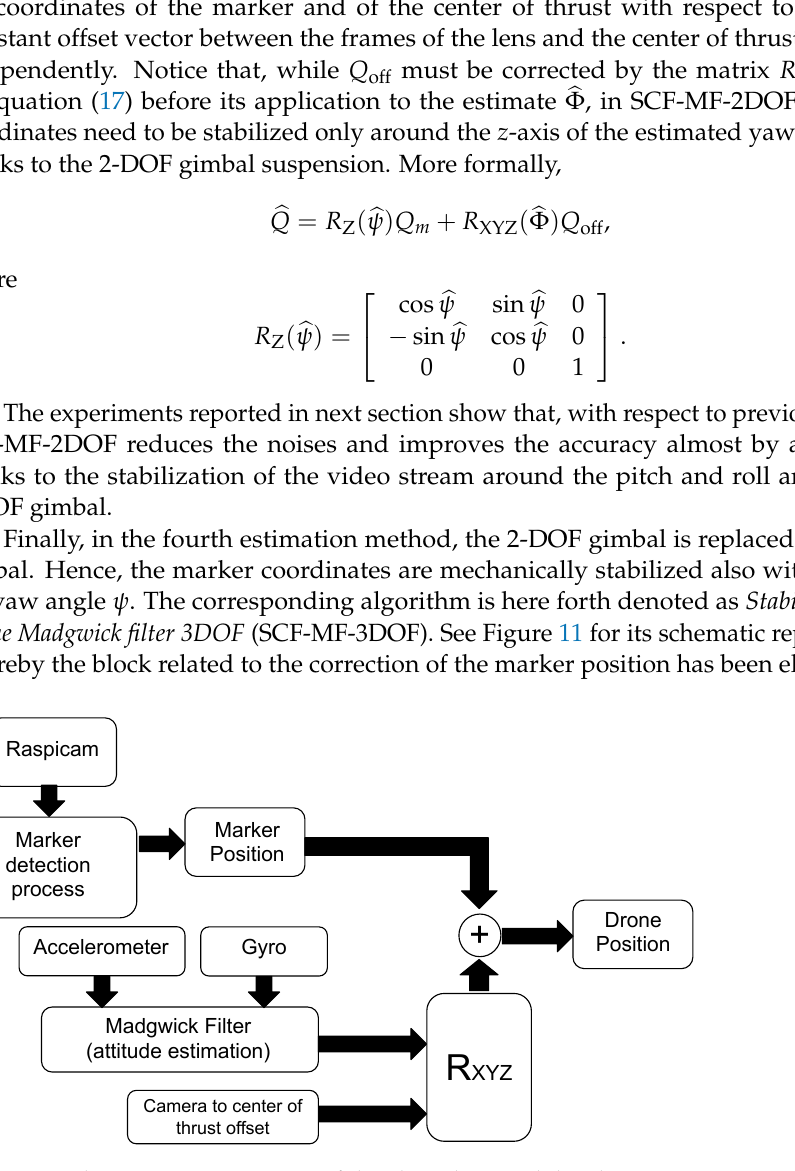
Figure 11. Schematic representation of the algorithm “Stabilized Camera Frame Madgwick filter 3DOF” (SCF-MF-3DOF). By improving the mechanical stabilization of the camera by means of a 3-DOF gimbal suspension, the marker coordinates Q m are directly summed, without being corrected, to the term R XYZ ( (cid:98) Φ ) Q off to obtain the estimation (cid:98) Q of the drone position. In this way, the noise on the video stream data is further mitigated, and also less calculations are necessary to carry out the estimation